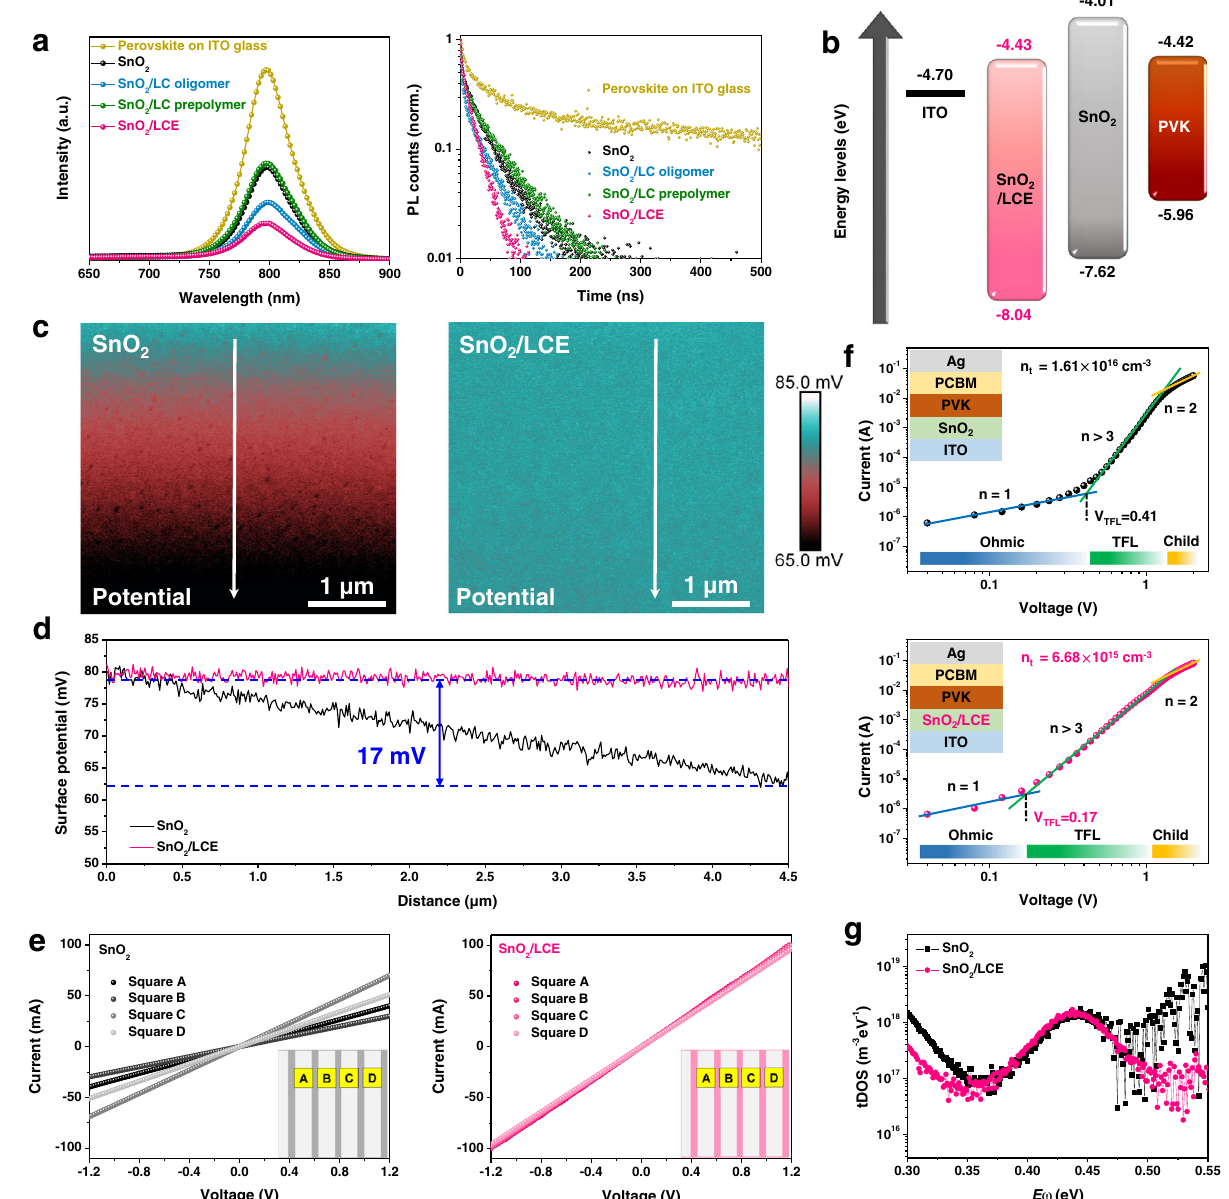
Fig.2|ChargetransferandrecombinationcharacterizationforSnO 2 andSnO 2 / LCE. a PL and time-resolved PL spectra of perovskite fi lms deposited on various substrates. b Schematic illustration of the energy levels. c KPFM images of SnO 2 fi lmswithout(left)andwith(right)LCE. d Linepro fi lestakenatthepositionmarked bywhitearrowsintheKPFMimages. e I – V curvesofdevicesbasedonthestructure